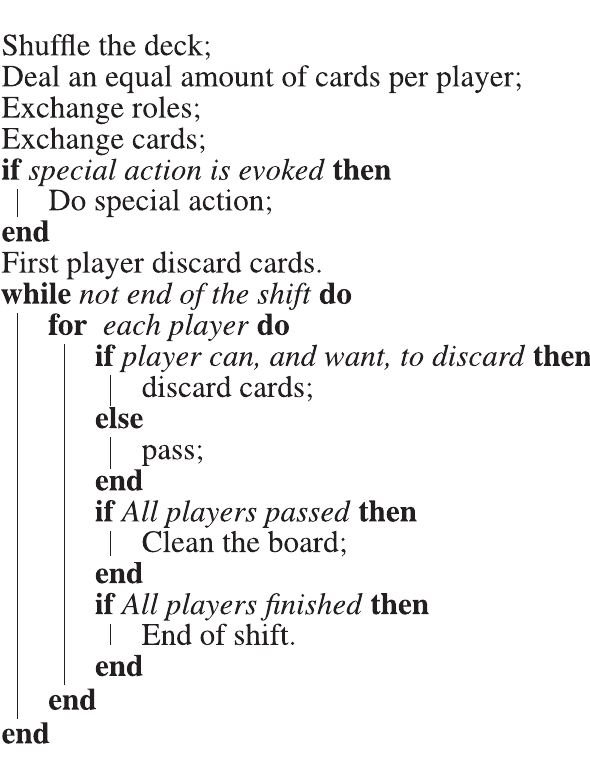
Algorithm 1 The playing fl ow of one Shift of the Chef ’ s Hat card